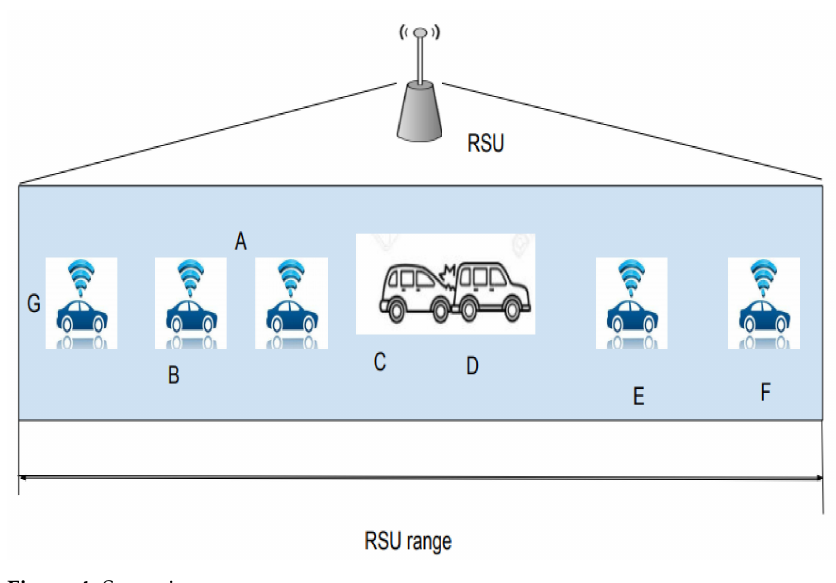
Figure 4. Scenario.